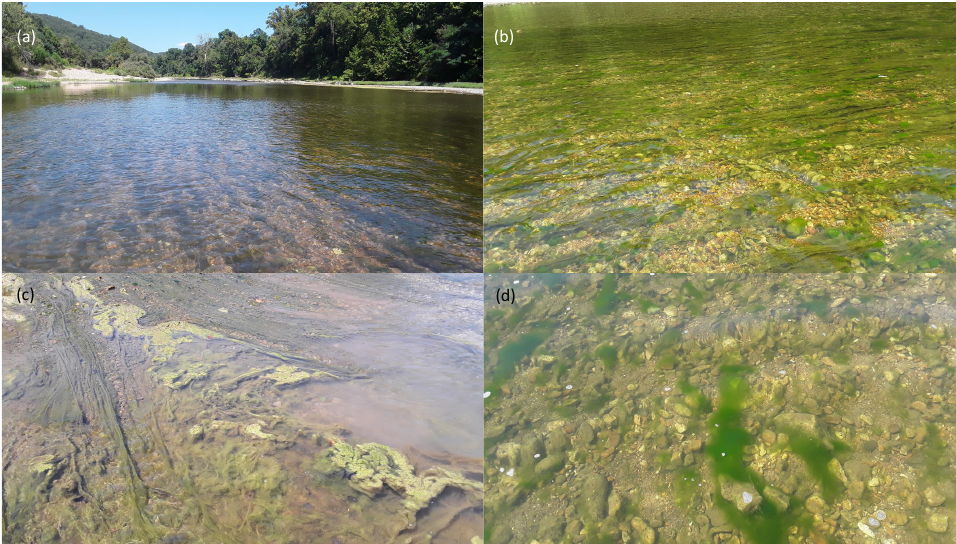
Figure 1. Photos of benthic algae along the Gilbert reach of the Buffalo River. ( a ) Provides an overview looking upstream and ( b – d ) illustrate the diversity of algal forms present within the reach. Photographs used with permission from Derek Filipek of the US National Park